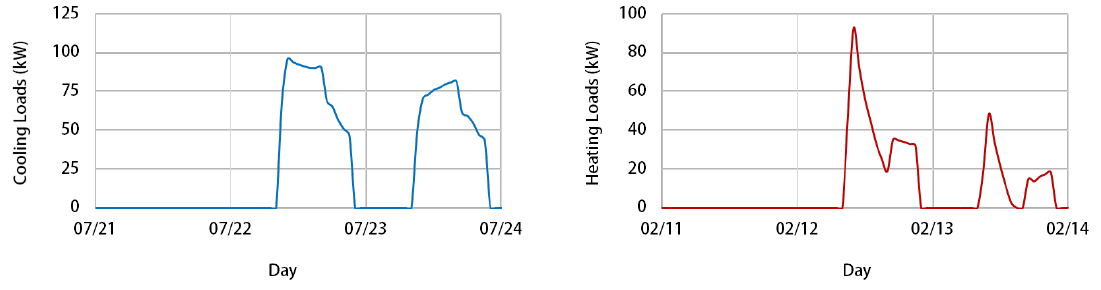
Figure 9. Daily cooling / heating loads of the school building.